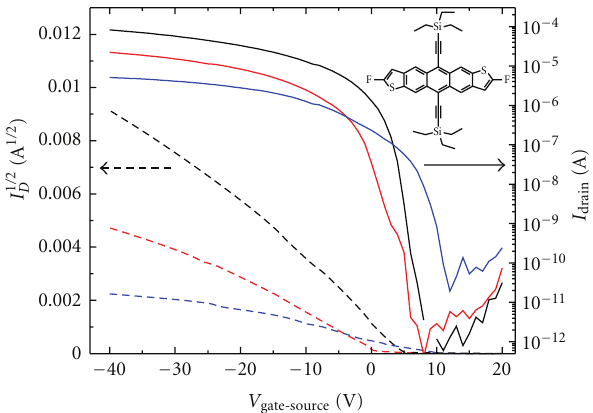
Figure 1: Current-voltage characteristics (drain current I D versus gate-to- source voltage V GS in saturation regime, V DS = − 40 V) for diF TES ADT devices sprayed from chlorobenzene (black), toluene (red) and dichlorobenzene (blue) solutions. The right axis corresponds to the solid lines and represents log( I D ), and the left axis corresponds to the dotted lines and shows the